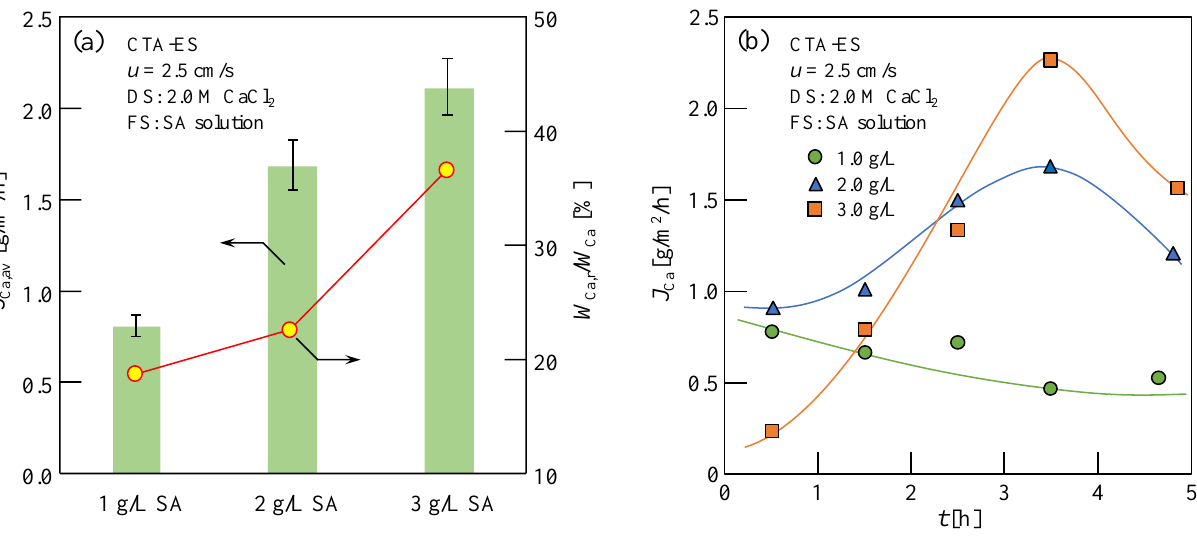
Figure 3. ( a ) Average RSF of Ca 2+ ( J Ca,av ) and percentage of Ca 2+ content in the CARP formed on the FO membrane ( W Ca,r ) to total Ca 2+ content ( W Ca ) in the FS containing Ca 2+ in the CARP, W Ca,r / W Ca for various SA solutions as the FS; ( b ) RSF of Ca 2+ without considering Ca 2+ in the CARP, J Ca , as the FO progressed. Here, 1–3 g/L SA solution and 2.0 M CaCl 2 solution were used as the FS and DS, respectively; for the flow rates of 2.5 cm/s, u along opposite directions on both sides of the membrane was used; CTA-ES, cellulose triacetate with embedded polyester screen support. The average water flux, J w,av , in the FO is also shown in Table 1.